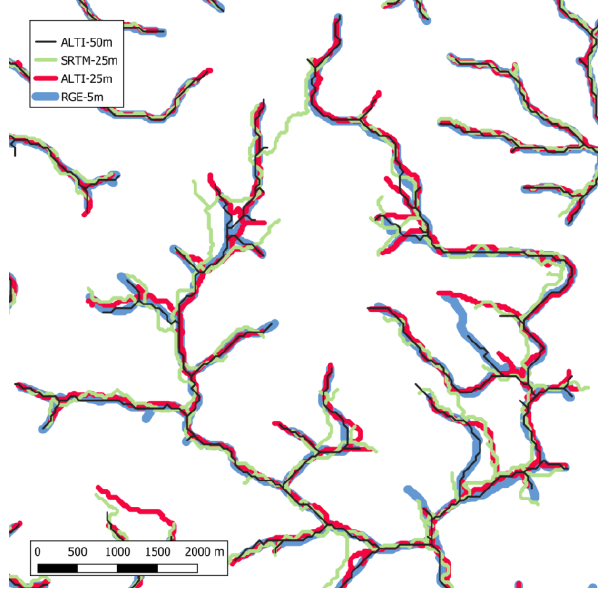
the basin surface S (Eq. 1).